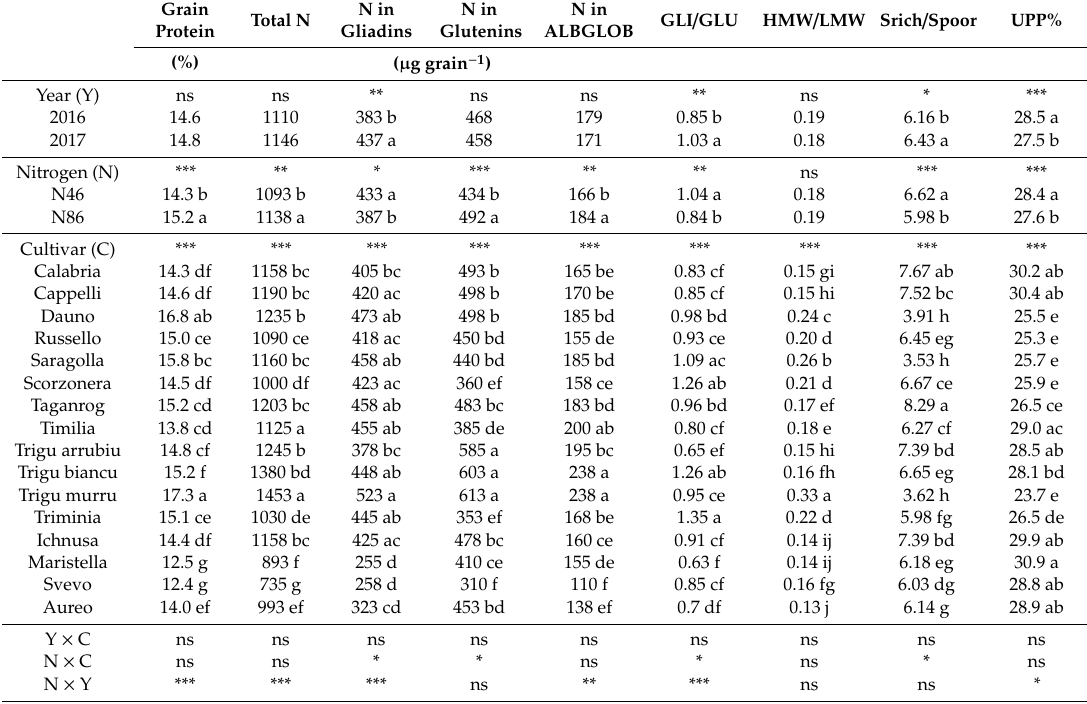
Table 3. Grain protein percentage, total grain N, N in gliadins, glutenins and albumins-globulins ( µ g of N in each component), the ratios gliadins to glutenins (GLI / GLU), high molecular to low molecular weight glutenins subunits (HMW / LMW) and sulfur rich to sulfur poor (Srich / Spoor), and unextractable polymeric proteins percentage (UPP%). Least Square Means and results of the analysis of variance.